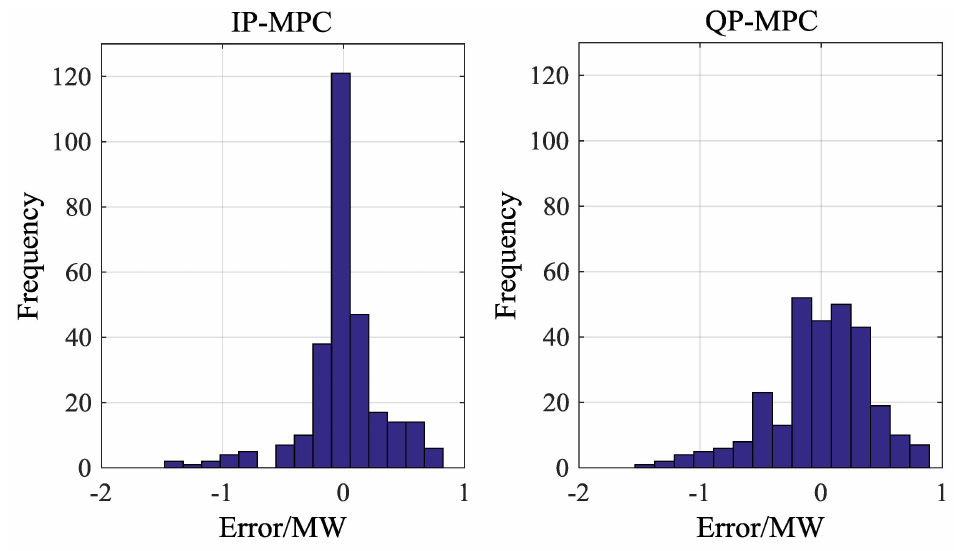
Figure 6. Frequency distribution of dispatching error (4.5 MWh). Table 1. Statistic result of dispatching error (4.5 MWh).